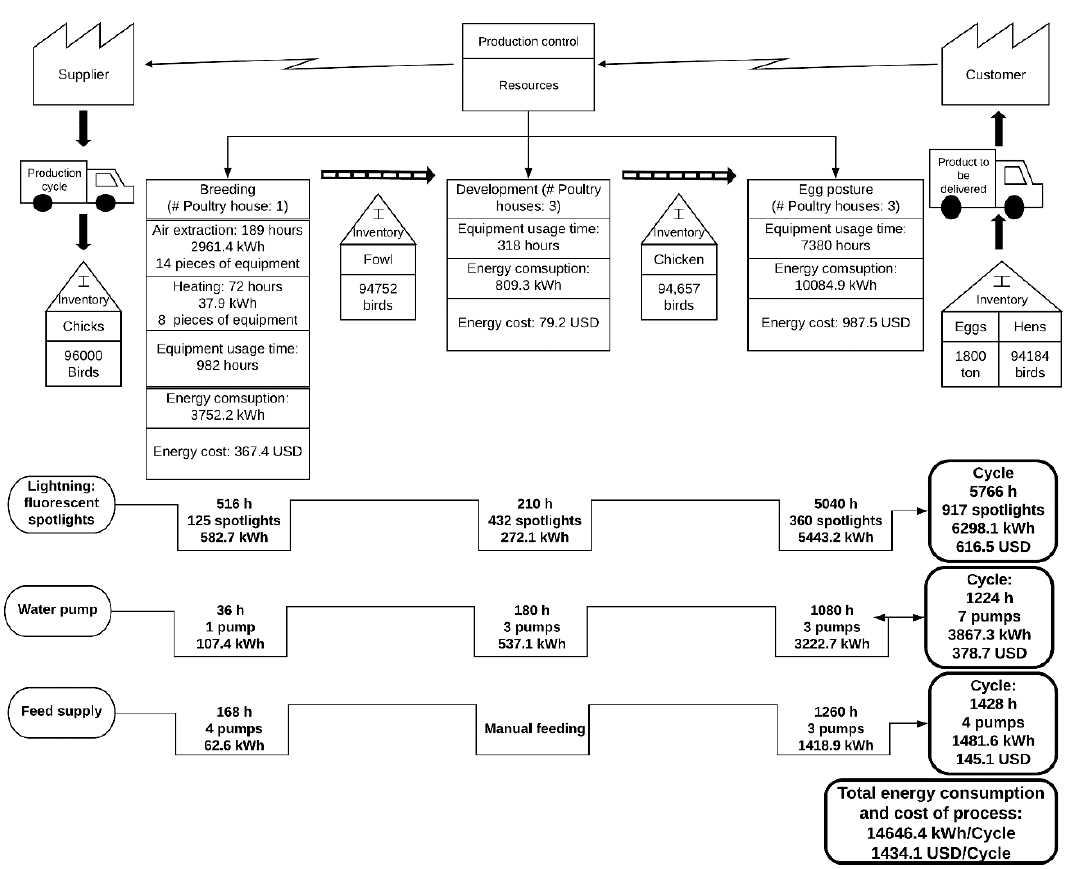
Figure 8. Consumption and cost of energy flows from unitary operations in egg production at current state. Table 7. Comparison of the energy expenditure of the current state vs. the eco-efficient scenario for the egg production process at Laguna Colorada farm.